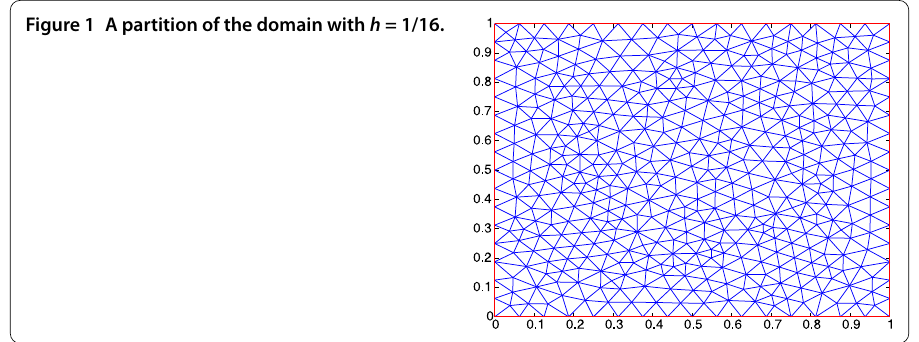
Figure 1 A partition of the domain with h = 1/16.